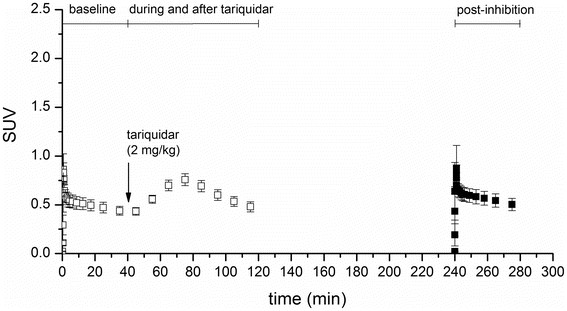
WB (R)-[11C]verapamil time-activity curves in humans. Average ± standard deviation (R)-[11C]verapamil concentration-time curves in human WB gray matter expressed as SUV at baseline (open symbols) and at post-inhibition (full symbols). Tariquidar (2 mg/kg) was administered 40 min after the start of the baseline scan as an infusion over 30 min (arrow).